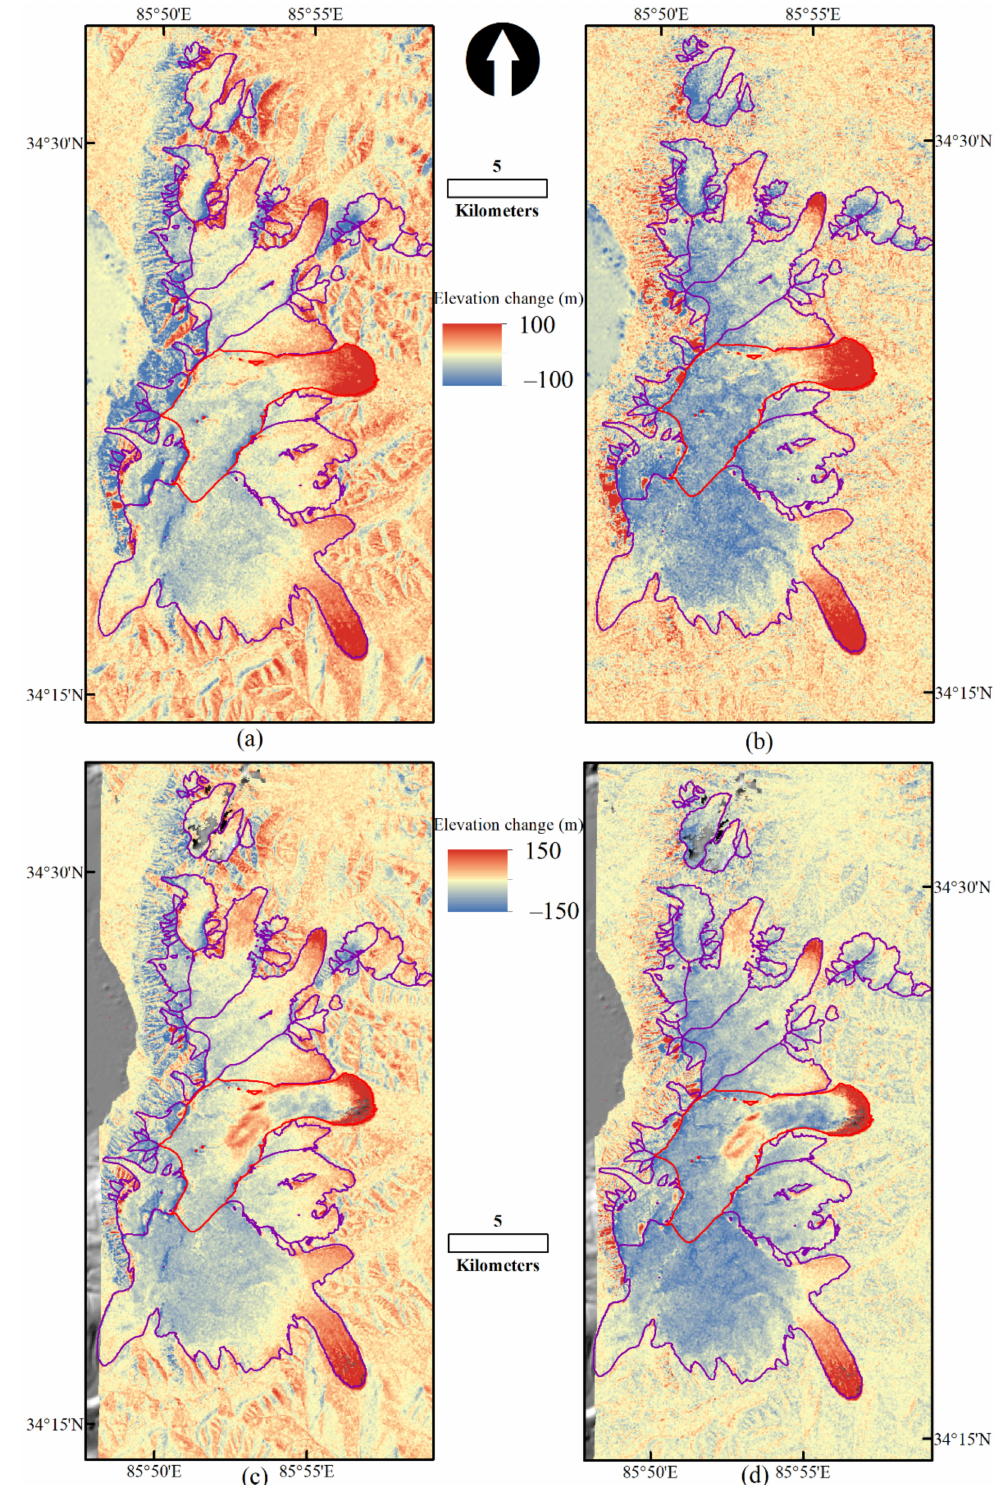
Figure A3. Elevation difference maps before ( a , c ) and after ( b , d ) the co-registration correction. ( a , b ) the difference maps between TDM90 and SRTM; ( c , d ) the difference maps between HMA and